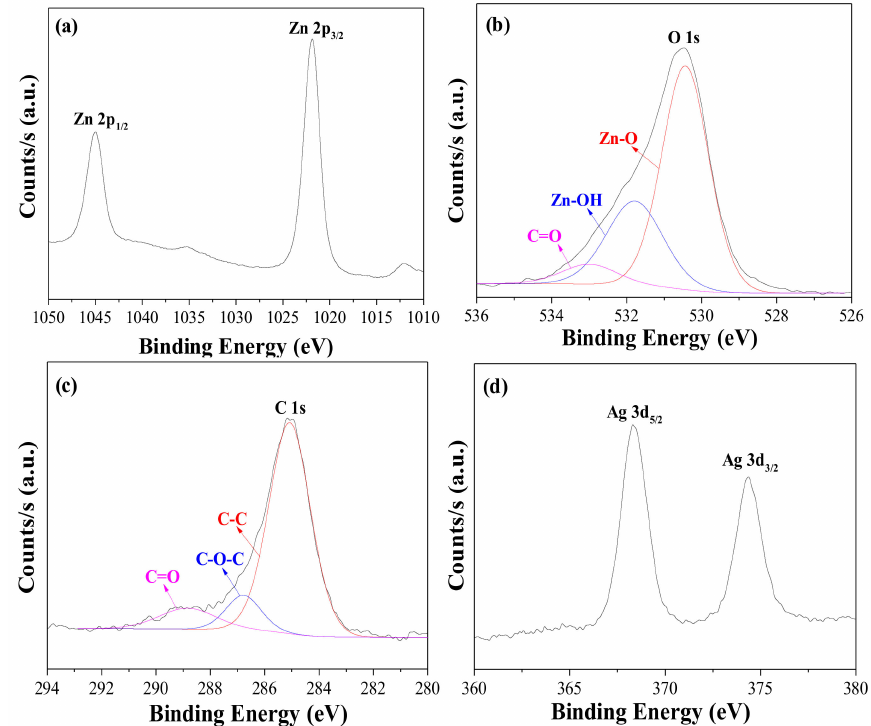
Figure 3. XPS spectra for ( a ) Zn 2p, ( b ) O 1s, ( c ) C 1s and ( d ) Ag 3d of Ag + (20)–ZnO/FTO